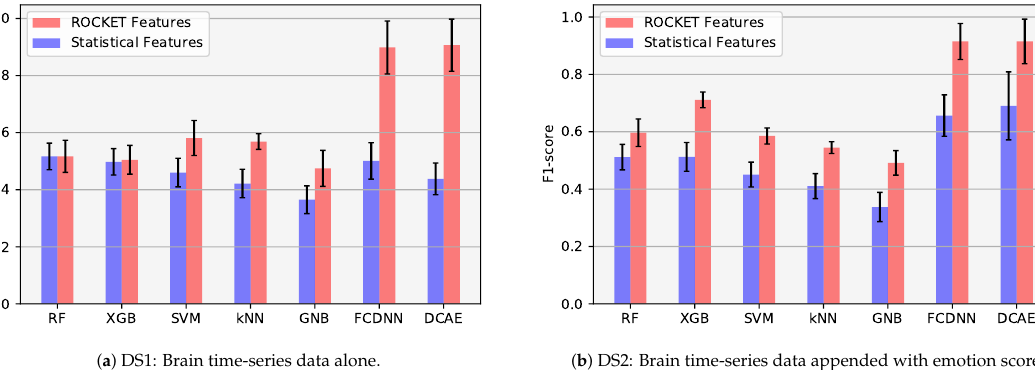
Figure 7. Comparison of mean F1 scores with standard deviation for all classifiers per trial for ( a ) DS1 and ( b ) DS2 using ROCKET and statistical